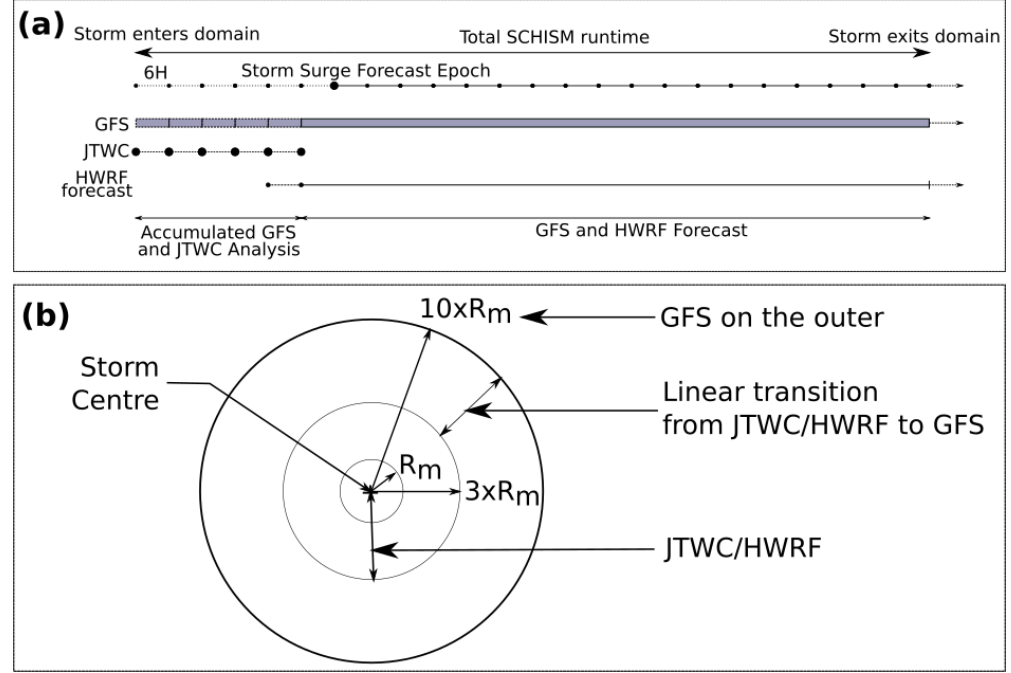
Figure 7. (a) Temporal combination scheme of the JTWC, GFS, and HWRF forecasts for each 6-hourly storm surge forecast epoch. (b) Spatial blending of the analytical and GFS wind and pressure field.